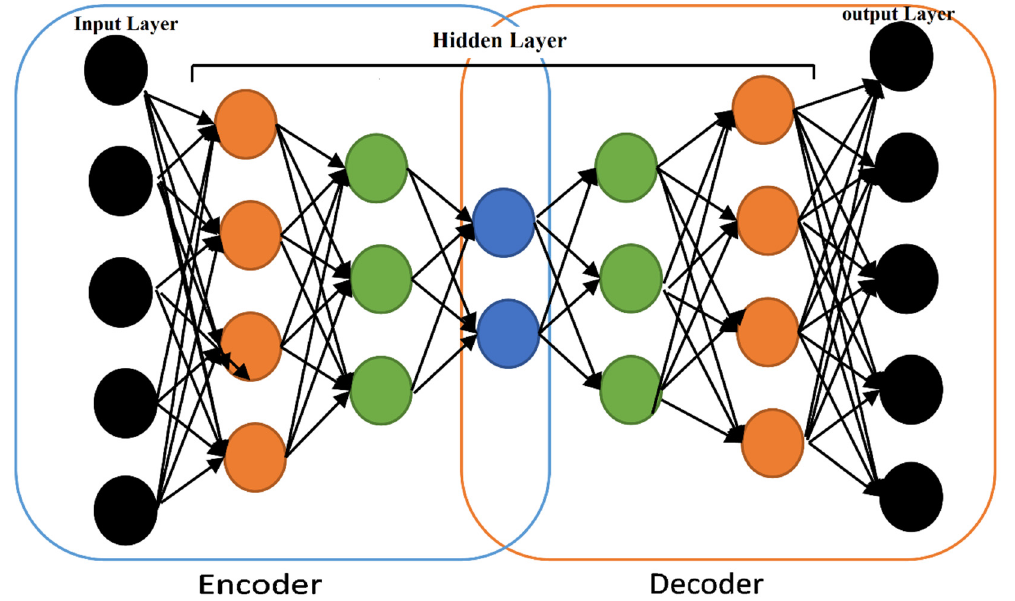
Figure 2. Deep autoencoder.